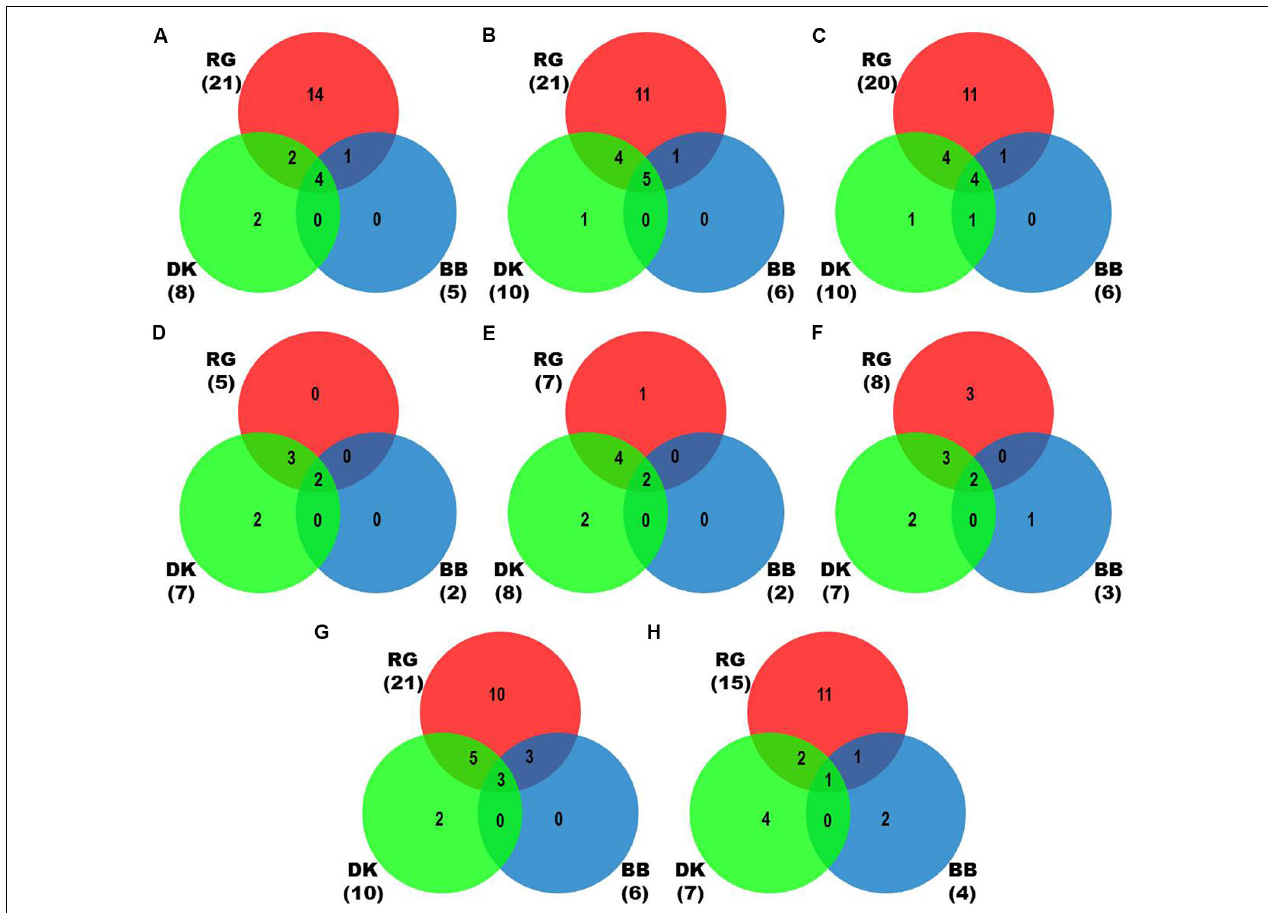
FIGURE 2 | Identification of viruses and viroids in three Indian grapevine cultivars – BB, DK, RG. Venn diagrams display the number of identified viruses and viroids based on Trinity assembled contigs from individual mRNA libraries of each cultivar (A) , Trinity (B) , SPAdes ( k = 21,23,25) assembled contigs from combined mRNAome of each cultivar (C) , CLC assembled contigs from individual sRNA libraries of each cultivar (D) , CLC (E) , Velvet ( k = 13,15,17) assembled contigs from combined sRNAome of each cultivar (F) , SPAdes ( k = 17,19,21) (G) and Velvet ( k = 17,19,21) (H) assembled contigs from whole transcriptome of each cultivar. Blue, green and red circles in the Venn diagrams represent the cvs. BB, DK, and RG,